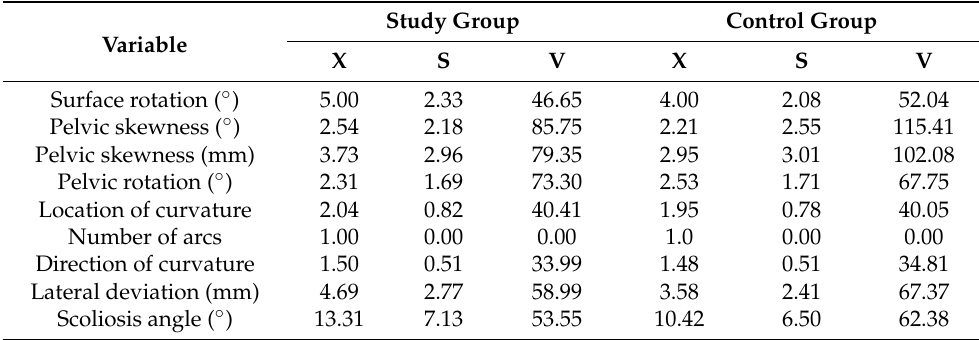
Table 3. Descriptive statistics regarding the examined variable parameters in the frontal plane among girls from the study and control group.